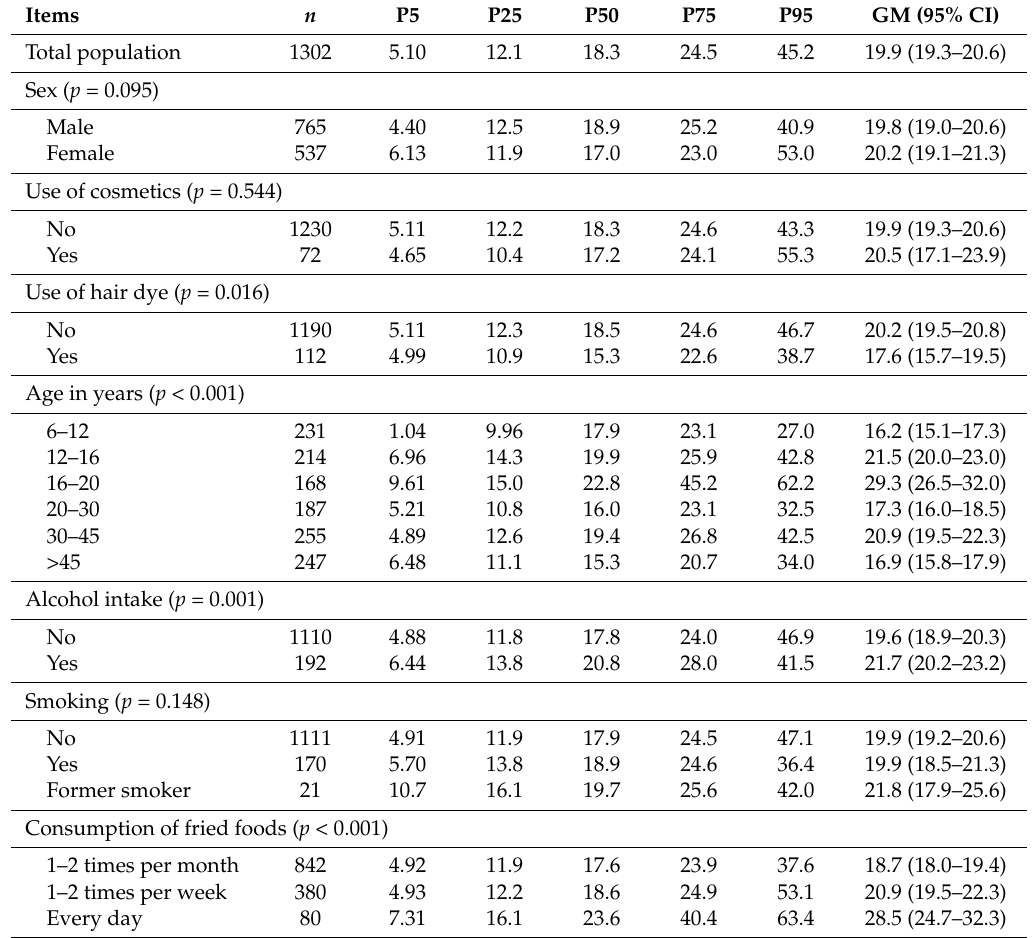
Table 2. Blood 72 Ge levels ( µ g/L), stratified by relevant categorical